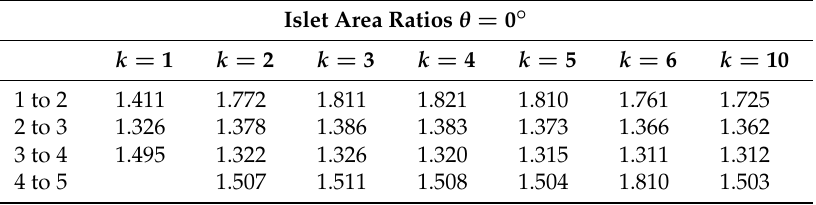
Table 1. The ratio of an islet’s area to an identified islet’s area for multiple k values when θ = 0 ◦ and c = 0. For k = 1, only four islets are present, whereas for the other k values there are five islets present. The table had an average standard deviation of 0.08205 between the data. This average standard deviation was found by averaging the standard deviation found for each row of